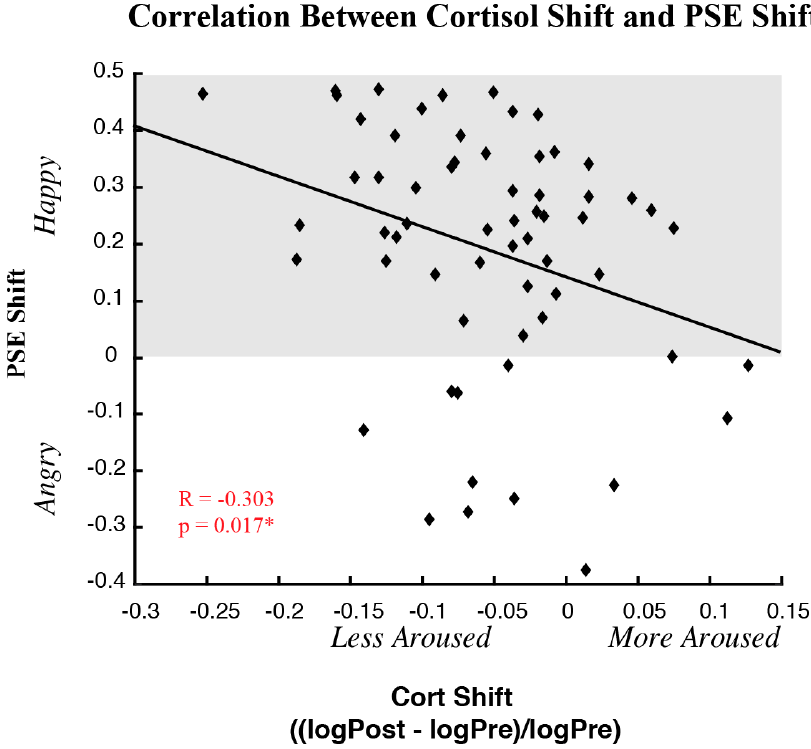
Figure 5. Correlations between cortisol and PSE shifts. Correlations between cortisol shifts and PSE shift across participants are shown collapsed across adapt conditions. The x -axis depicts cortisol shift, with positive values indicating an increase and negative values a decrease in cortisol levels post-adapt relative to pre-adapt. The y -axis depicts PSE shift, with positive values indicating an increase in happy judgements and negative values indicating an increase in angry judgements, relative to baseline. There was a significant negative correlation between cortisol and PSE shift across adapt conditions ( r = − 0.303; p = 0.017) (* indicates p ≤ 0.05).